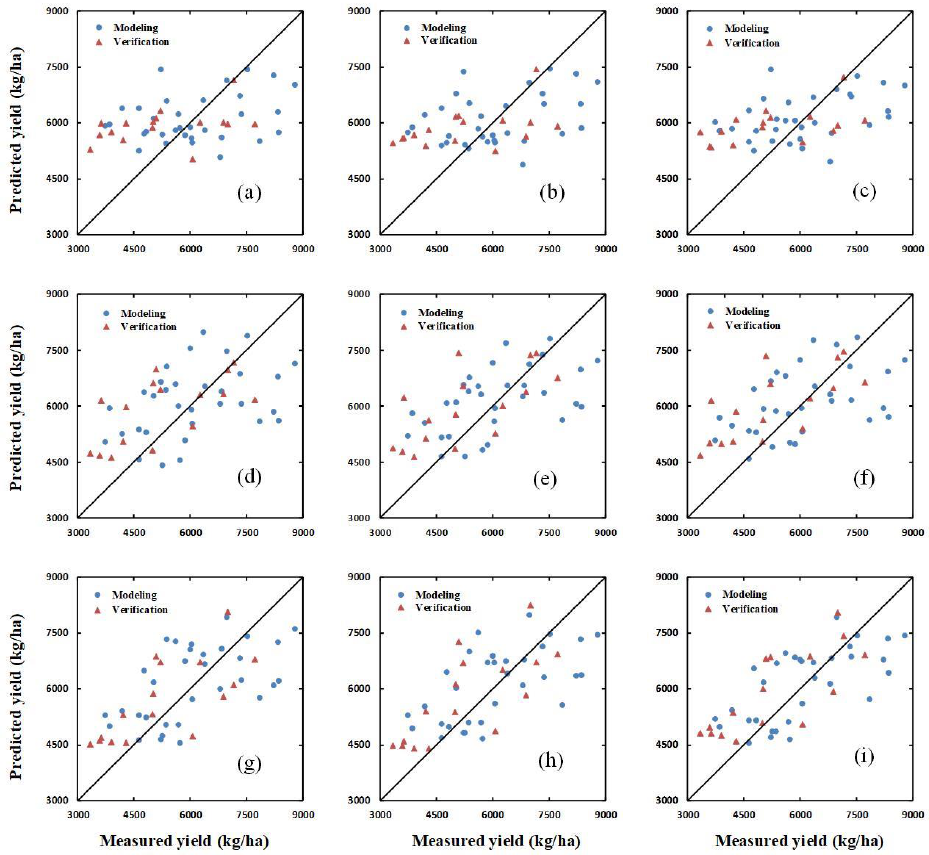
Figure 8. The relationships between the ground-measured and predicted values of winter-wheat yield at di ff erent growth stages based on the random forest (RF) method. ( a – c ) show the results for SIs, a combination of SIs and H, and a combination of SIs and H CSM , respectively, at the jointing stage. ( d – f ) show the same as ( a – c ) for the flagging stage; and ( g – i ) show the same as ( a – c ) for the flowering stage.